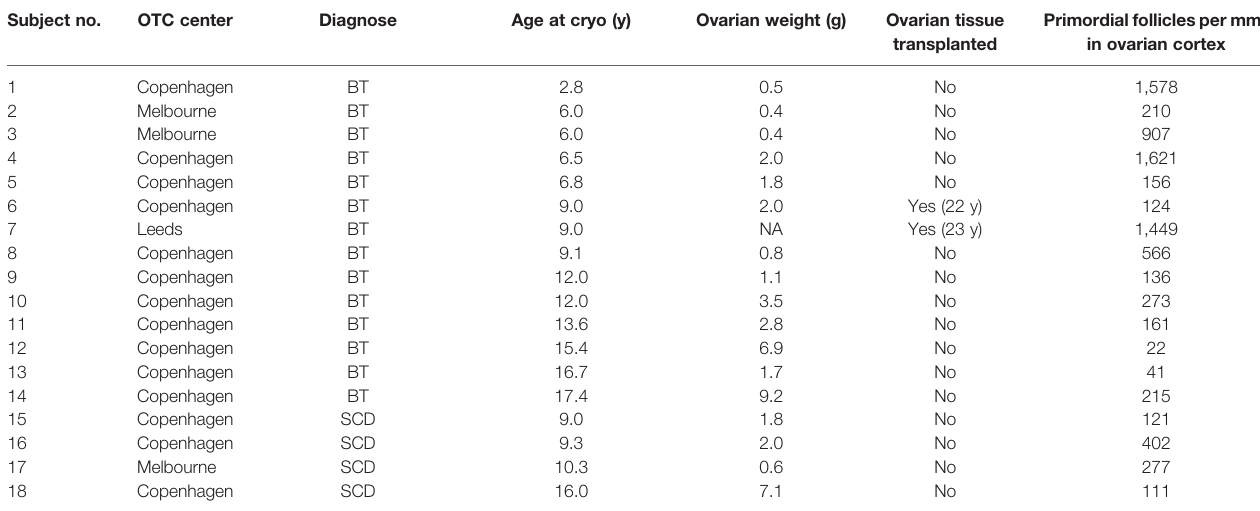
TABLE 1 | Clinical data on b -thalassemia (BT) and sickle cell disease (SCD) patients. Subject no. OTC center Diagnose Age at cryo (y) Ovarian weight (g) Ovarian tissue